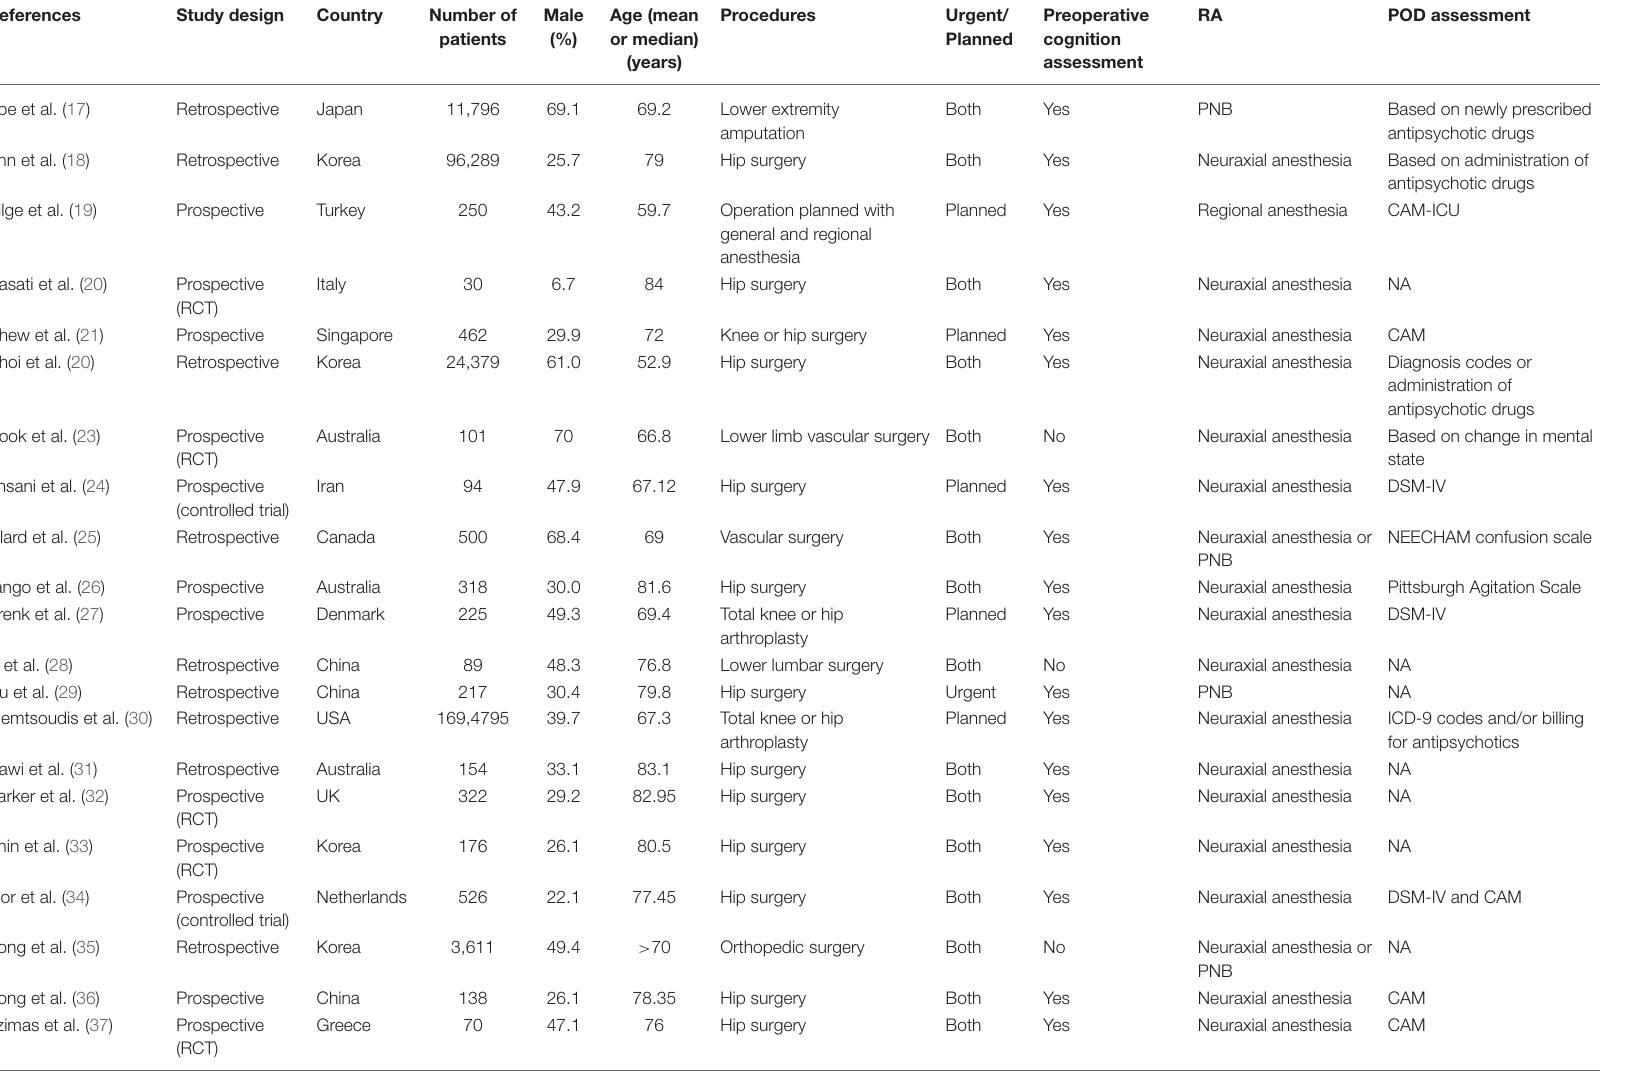
TABLE 1 | The basic characteristics of included